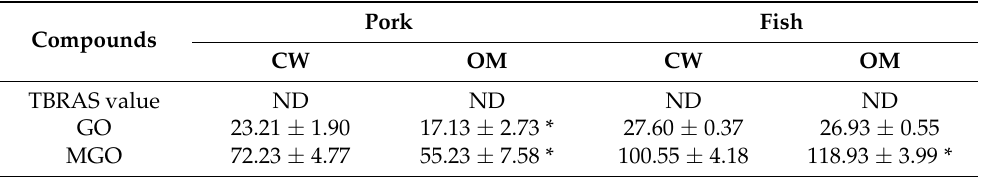
Table 2. The amount of thiobarbituric acid reactive substances (TBARS) values (mg MDA/kg sample), GO ( µ g/kg sample), and MGO ( µ g/kg sample) in pork and fish samples under conventional water- washing (CW) treatment and ozone-microbubble-washing (OM)